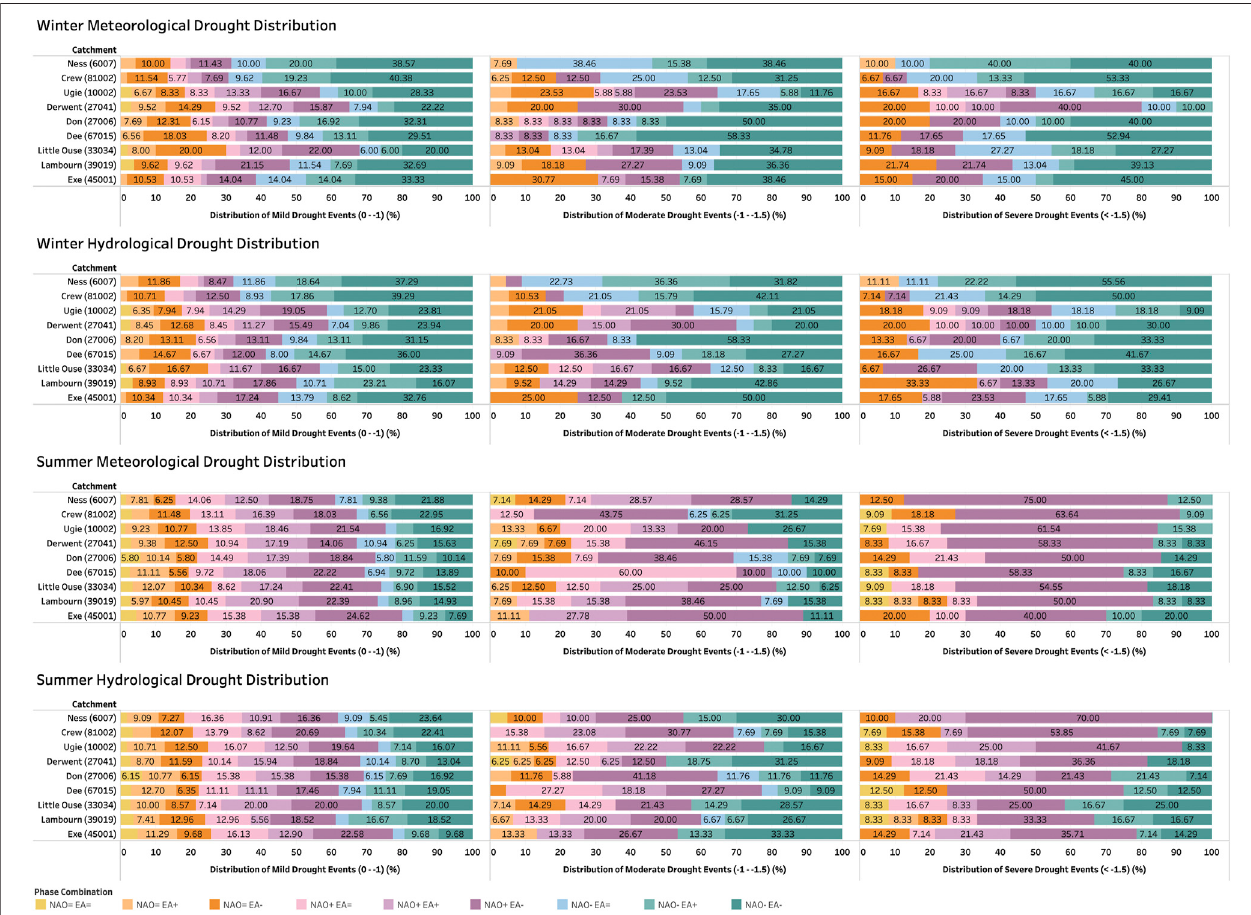
FIGURE 10 | Distribution of mild (0 > index < − 1), moderate ( − 1 > index < − 1.5) and severe (index < − 1.5) droughts under phases combinations of NAO and EA. Values represent the percentage of time drought events of different severities occur under the different phase combinations.